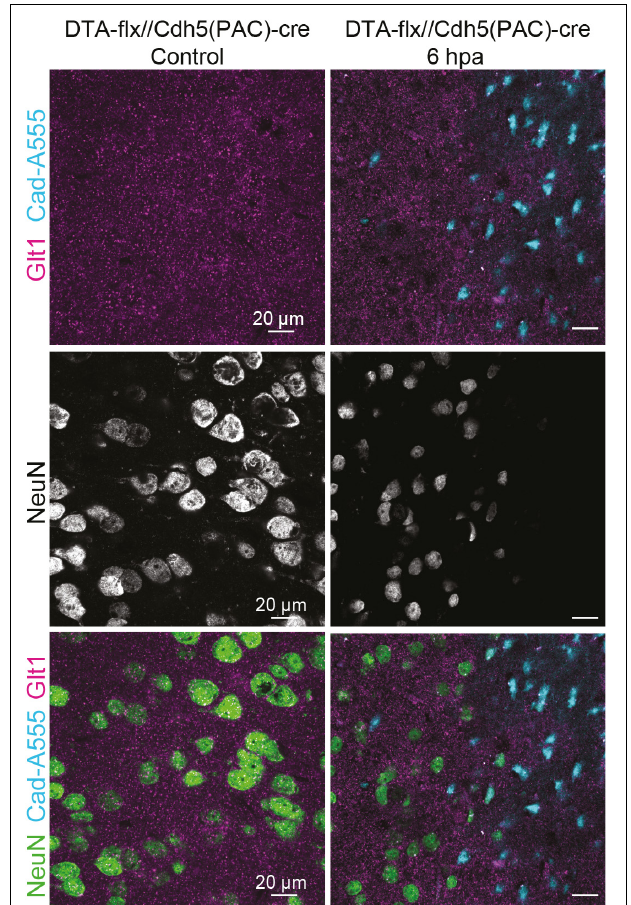
FIGURE 5 | Cadaverine leakage induced by endothelial-cell ablation is sufficient to trigger atypical NeuN expression without a mTBI. Representative images of the control are located on the left and 6 h post Endothelial-cell ablation images are located on the right (Blue: Cad-A555, Magenta: Glt1, B&W: NeuN, Green: